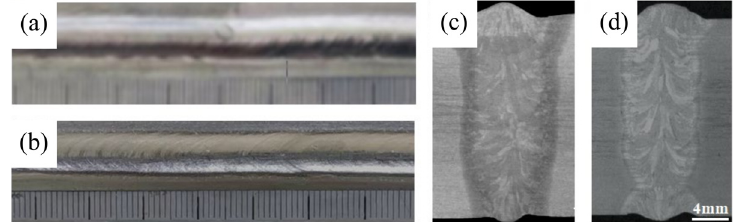
Figure 4. Comparison of the macromorphology of welded joints with flux-cored wire and cable wire welding joints: ( a , c ) flux-cored wire welding joints; ( b , d ) cable wire welding joints.